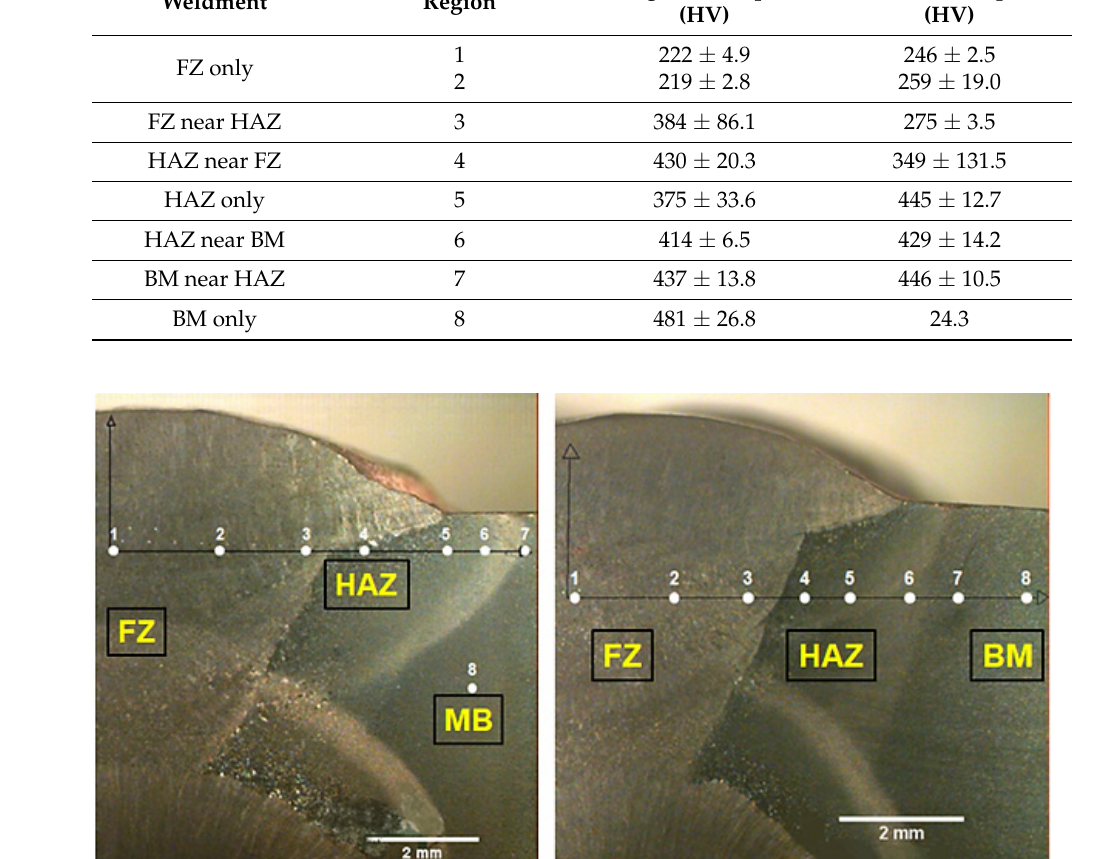
Figure 12. Graphical profile of microhardness measurements along the transversal section of the welded HHA steel for both heat input conditions. According to the microstructure, Figure 11, and the microhardness profile, Figure 12, it was possible to identify, on both heat input conditions, eight different regions: • 1st and 2nd region: with low microhardness, associated with the FZ only, where the filler metal is predominant. This region has a ductile microstructure of polygonal fer- rite (219–259 HV). However, the grain size resulting from the LHI condition is smaller than that related to the HHI condition in Figures 9a and 10a. Most possibly the in- crease in heat input contributes to growing the grains. This might be the reason why